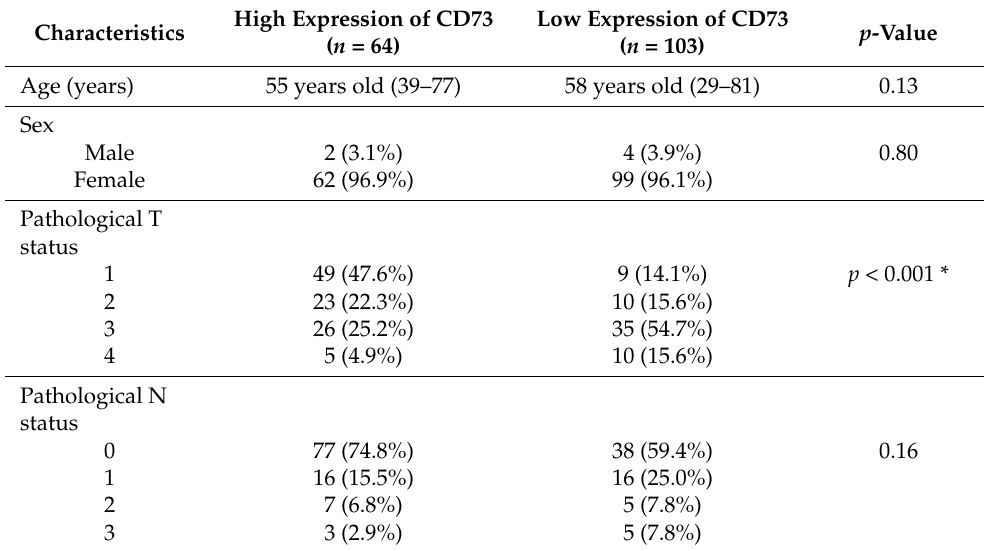
Table 1. Characteristics of 167 patients with esophageal squamous cell carcinoma receiving surgical